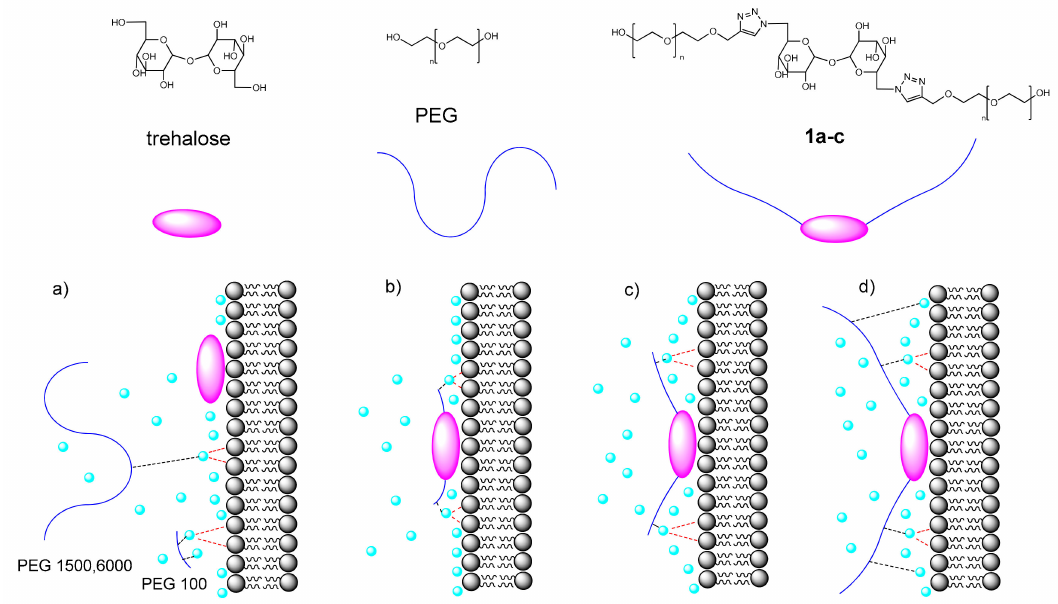
Figure 4. Proposal of chelate e ff ect: ( a ) The proposed destabilization of polar lipid heads through hydrogen interactions of PEGs with membrane water [21,32] the interaction of polymer chains of PEG 1500 and PEG 6000 to the water which bound to membranes is weaker in comparison with short PEG 100. The assumed stabilizing e ff ect of cell membranes by trehalose displacement with water; ( b ) The short pegylated linkage of 1a prevents a high destabilization of cell membrane; ( c ) Approaching middle PEG-chains to cell membrane increases the probability for stronger hydrogen interactions with water resulting in the destabilization of membrane at the concentration comparable with pegylated hybrids 1b ; ( d ) the more flexible pegylated hybrid 1c may partially deflect its PEG-tentacles from the membrane